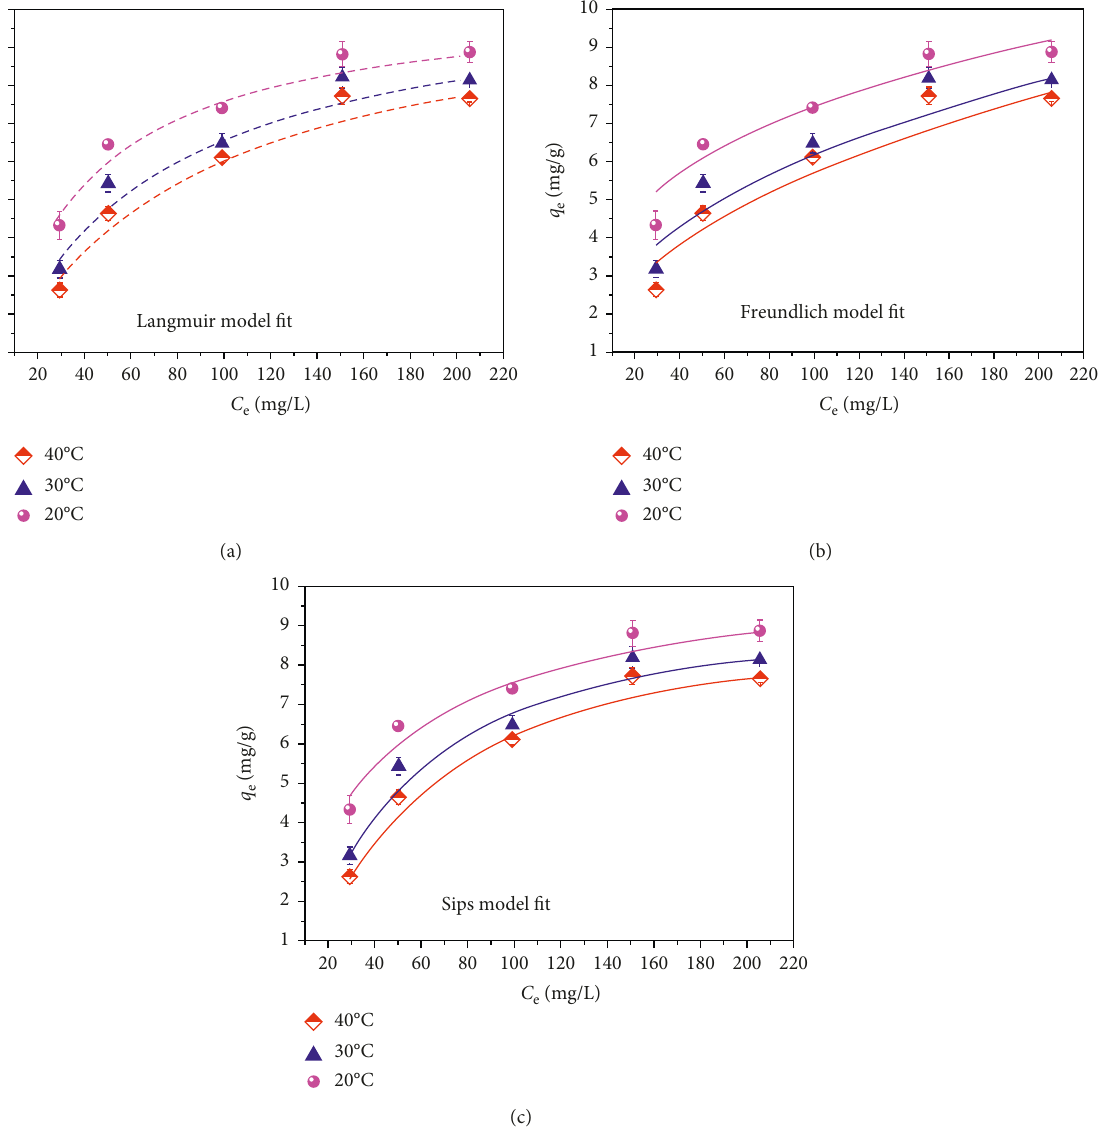
Figure 5: Effect of initial Cr(VI) concentration on Cr(VI) adsorption onto FSS at various temperatures; pH 2; 120min of contact time; 4g/L of adsorbent